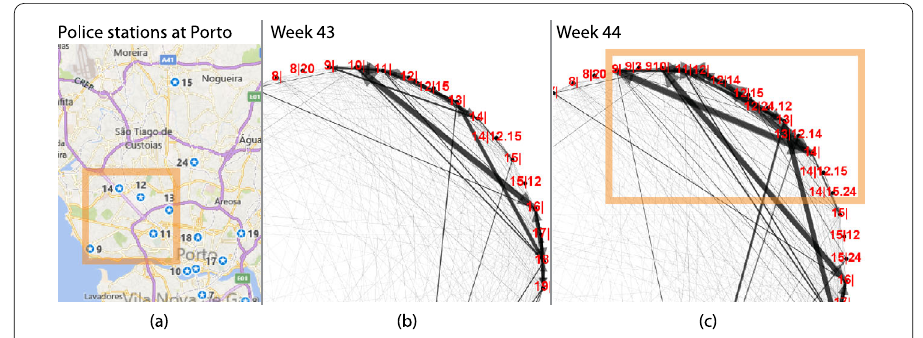
Figure 8 ( a ) Labeling of police stations in urban areas of Porto. ( b ) and ( c ) the emergence of higher-order traffic patterns in week 43 and 44 (“Burning of the Ribbons” festival) captured by HON, corresponding to the highlighted region in ( a